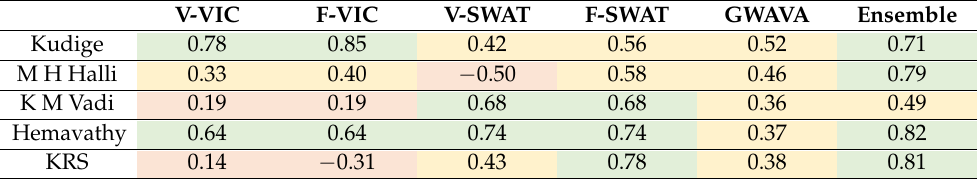
Table 3. The KGE values obtained from monthly streamflow for the five catchments for each model from 1986–2003. The values lying in the green shaded area are considered by this study as ‘good’, the yellow area as ‘fair’ and the red area as ‘poor’.